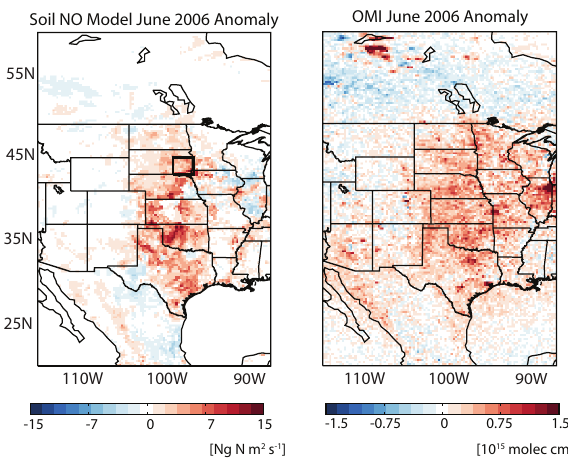
Fig. 4. The June 2006 modeled Soil NO x anomaly is compared to the OMI tropospheric NO 2 column anomaly over the central United States. The anomalies are calculated as in Fig. 3a. Boxed region (43–45 ◦ N, 98.75–96.25 ◦ W) shown is used in case-study in Sect. 5 of